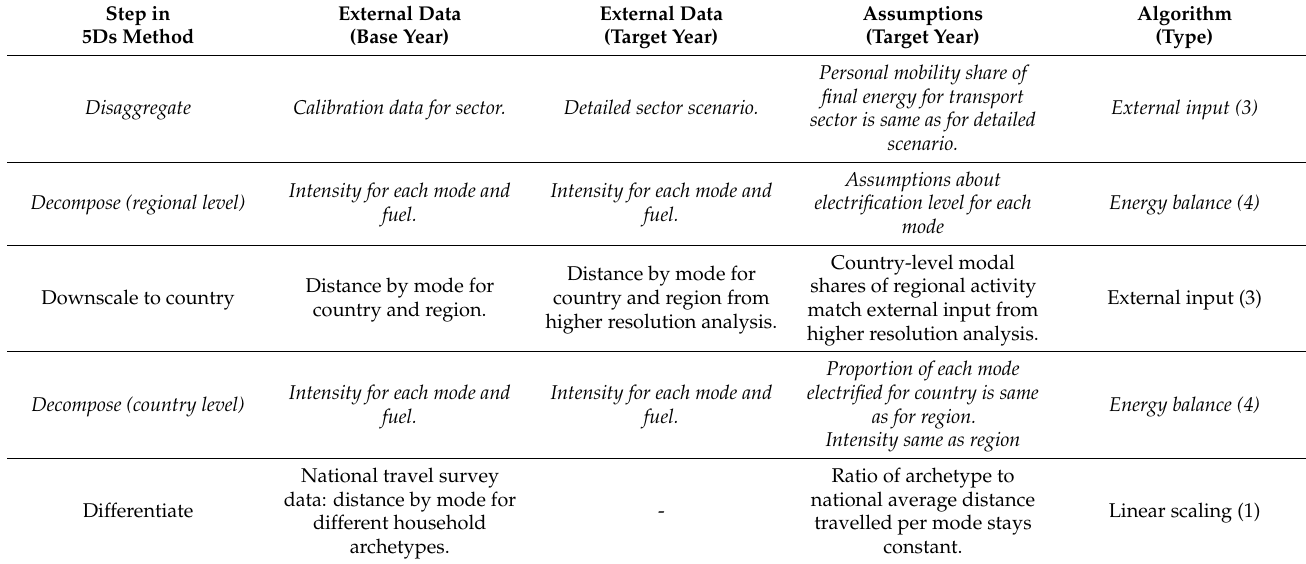
Table 4. Summary of data, assumptions, and algorithms for calculation steps applied to